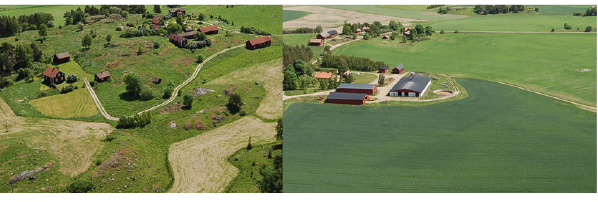
Fig. 3 . Photos from NDB representing a) a traditional agricultural landscape, common in the late 1800s, with seminatural grasslands and relatively small crop fields, and b) an agriculture landscape dominated by crop fields, common at present. Photos by S.